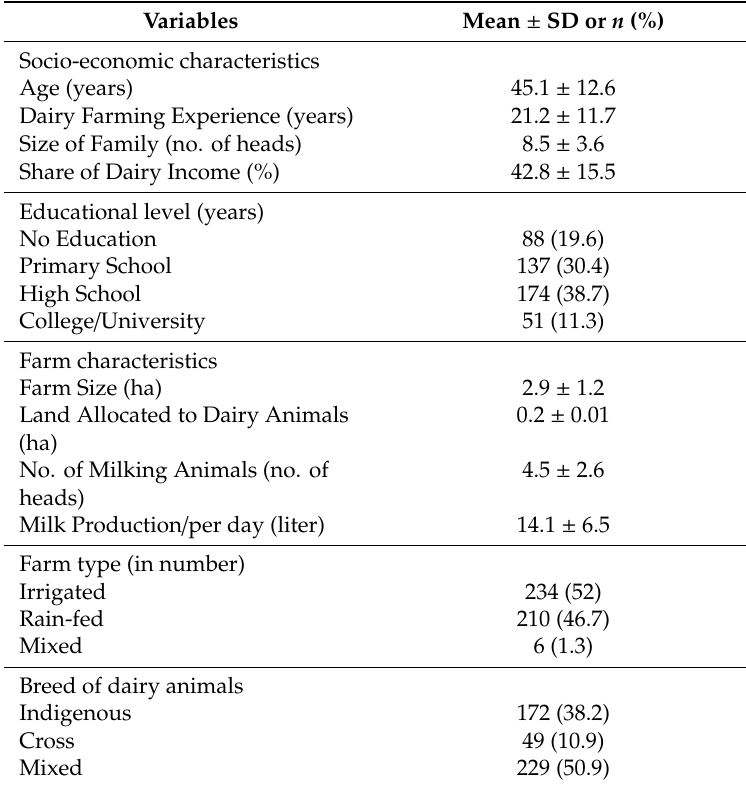
Table 2. Summary statistics of surveyed dairy farmers ( n =